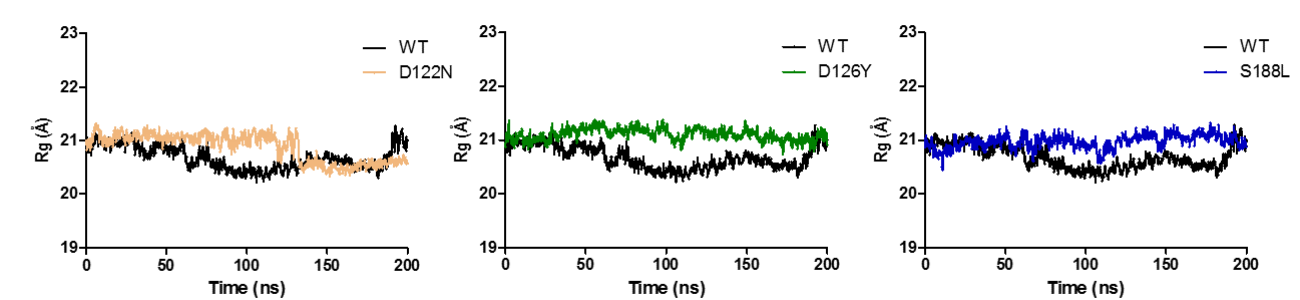
Figure 9. Analysis of the molecular dynamic trajectories over 200 ns by radius of gyration (Rg) plots